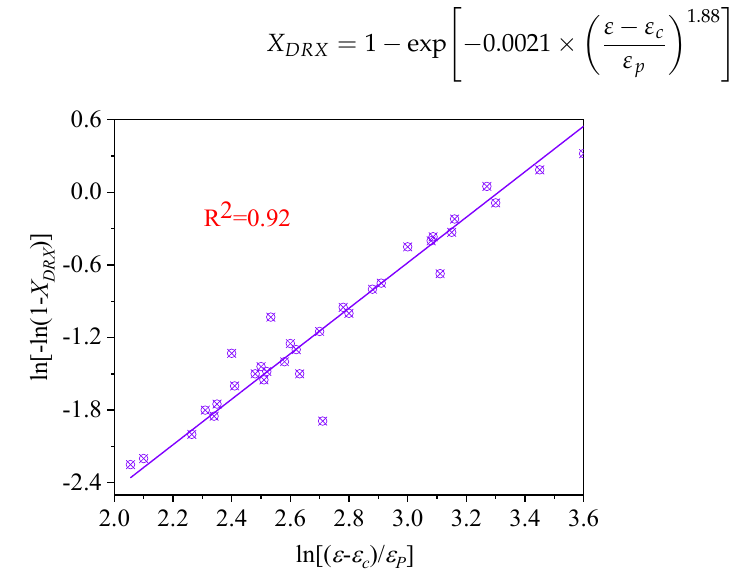
[( - )/ ] ln    . Figure 7. Relationship between ln [ − ln ( 1 − X DRX )] and In [( ε − ε c ) / ε p ] p c